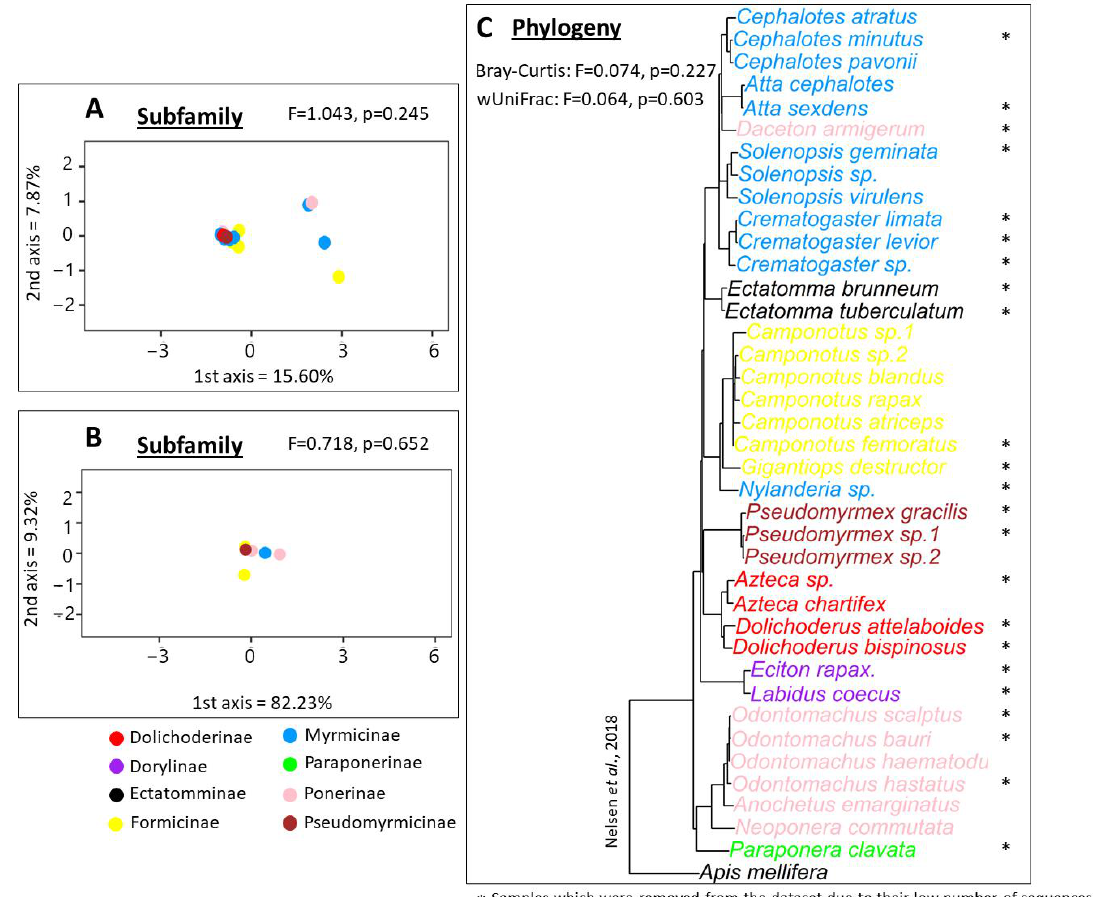
Figure 4. Differences in microbial eukaryote communities visualized with PCoAs across ant habitats ( A , B ), nesting modes ( C , D ), and diets ( E , F ). The distances used were the Bray – Curtis ( A , C , E ) and wUniFrac ( B , D , F ). The statistical p -values were obtained with pairwise PERMANOVAs. The circles represent confidence intervals of 0.95.